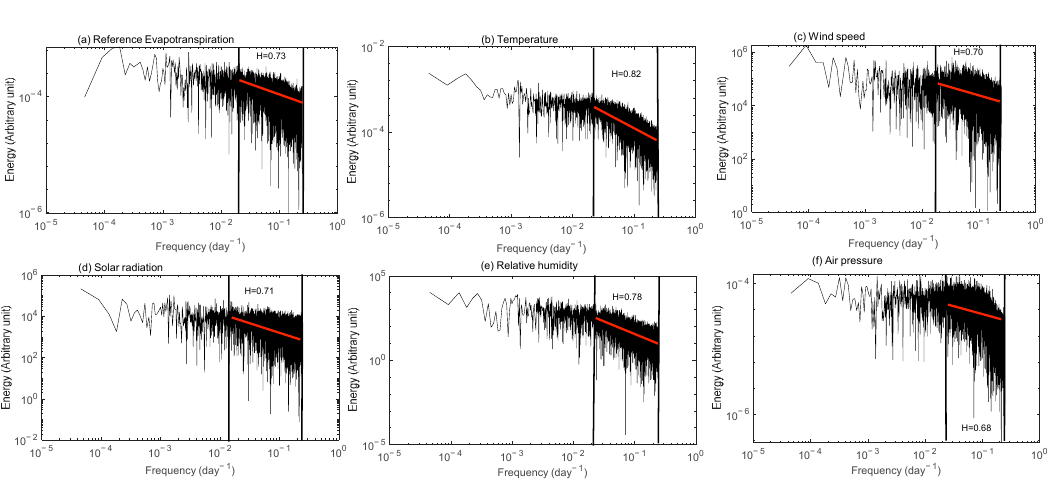
Figure 5. Fourier spectrum of different agro-meteorological time series of Dagget station. ( a ) reference evapotranspiration; ( b ) temperature; ( c ) wind speed; ( d ) solar radiation; ( e ) relative air humidity; and ( f ) air pressure.